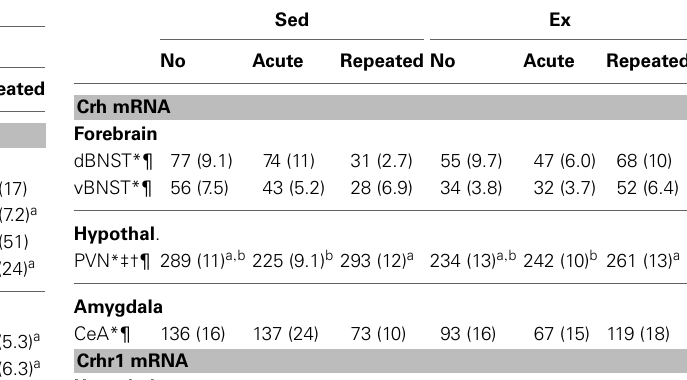
Table 1 | Stress and voluntary exercise effects on central Fos mRNA expression.